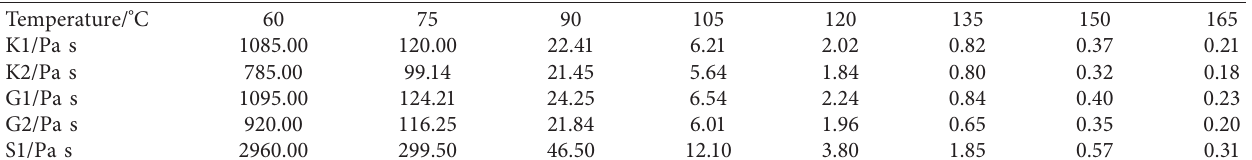
Table 2: Viscosity of asphalt with different temperature.